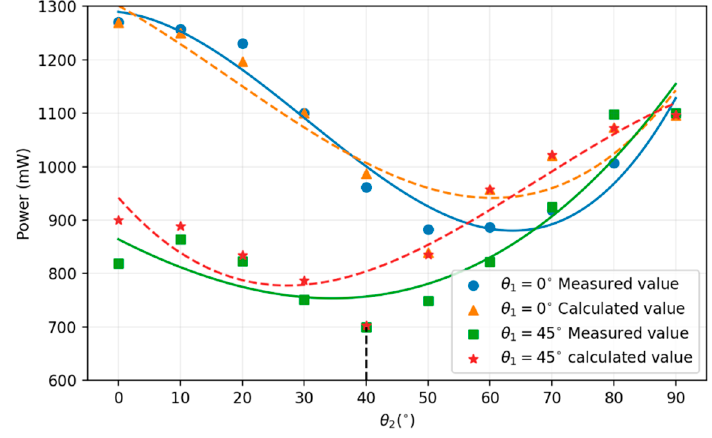
Figure 10. Received power at various attitudes.